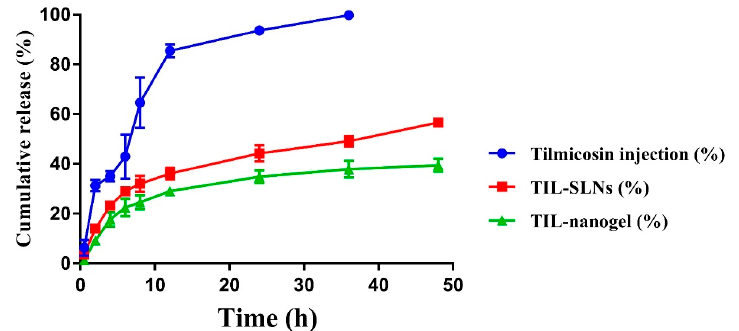
Figure 4. The cumulative release of TIL-SLNs and TIL-nanogel at pH = 7.5.